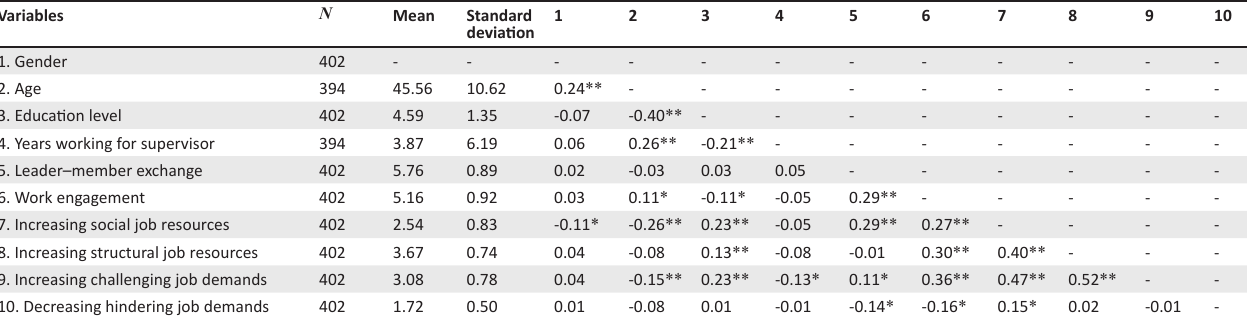
TABLE 1: Descriptive statistics and correlations.